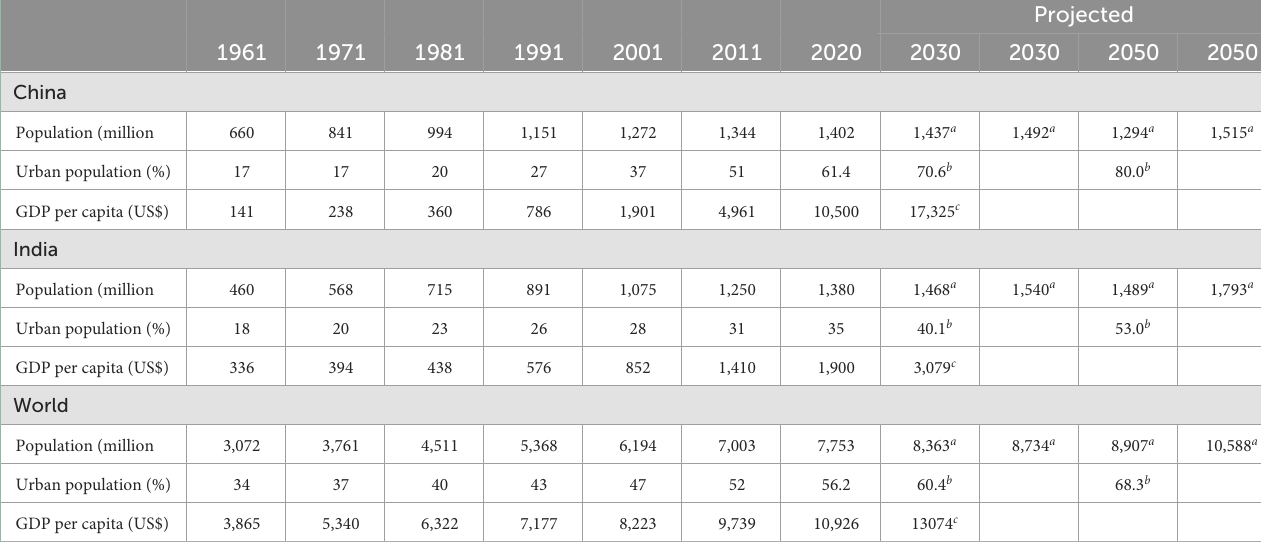
TABLE 3 Temporal changes and projection of population (million), the share of the urban population, and GDP per capita (US $)